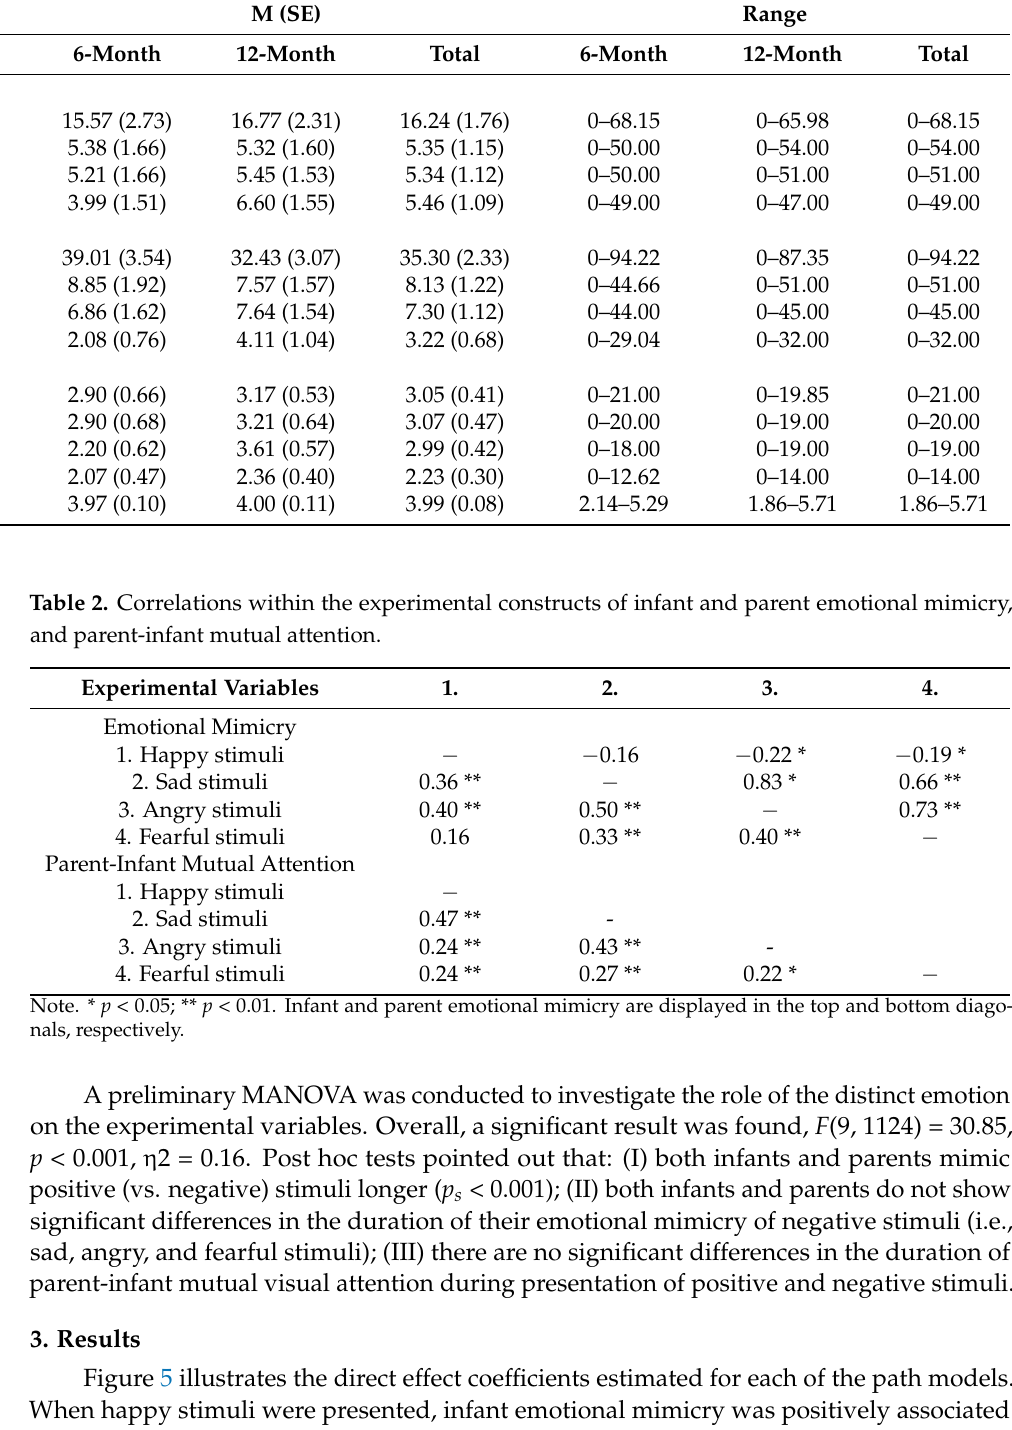
Table 1. Descriptive statistics of the experimental variables ( N 6-month = 51; N 12-month = 66; N total = 117). Experimental Variables